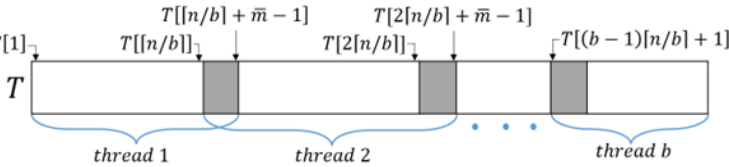
Figure 2. Search phase of the parallel OPMPM algorithm using the Aho–Corasick automaton. Algorithm 2 Search